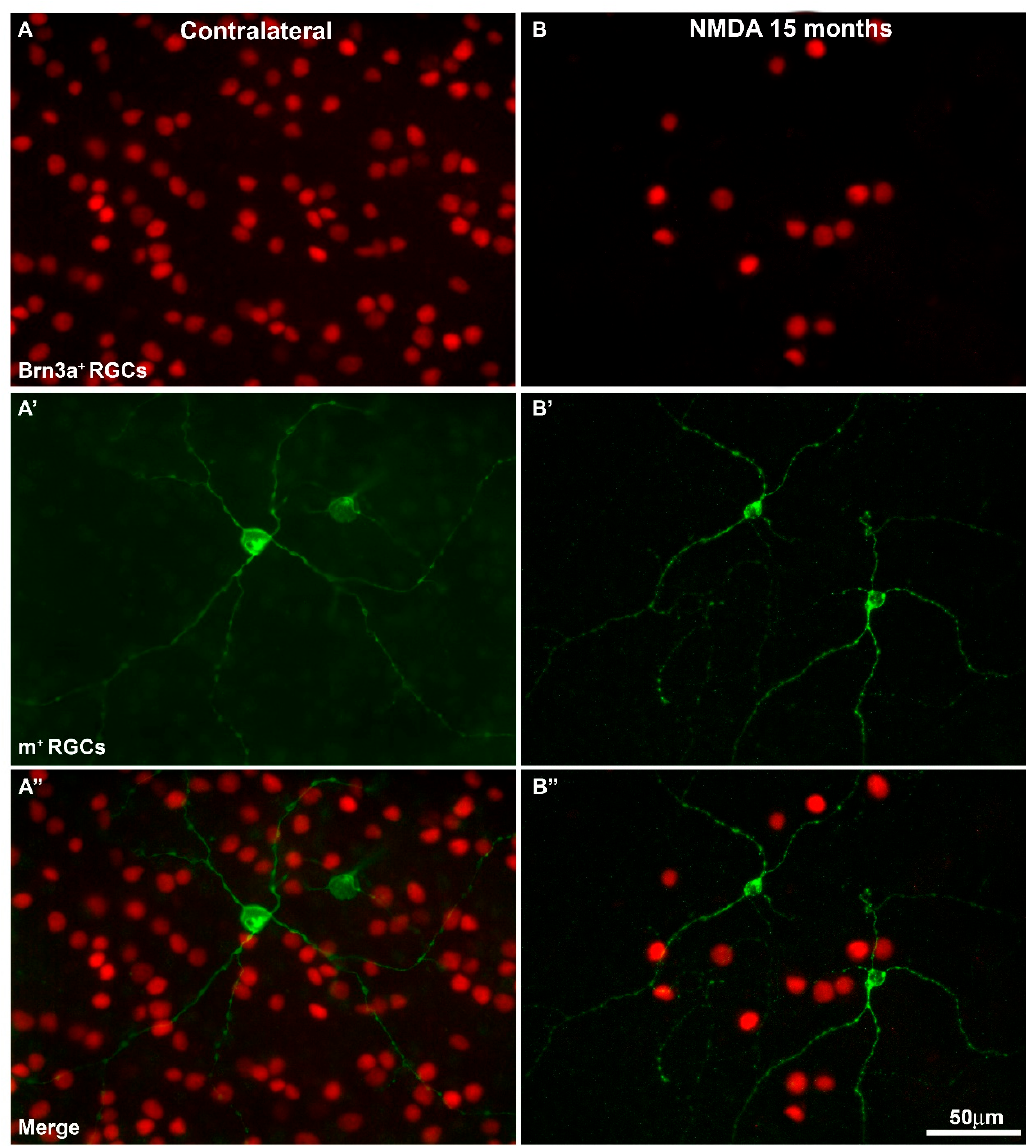
Figure 1. Magnifications from flat mounted retinas showing brain-specific homeobox / POU domain protein 3A positive retinal ganglion cells Brn3a + RGCs ( A , B ) and melanopsin positive retinal ganglion cells m + RGCs ( A’ , B’ ), and both signals (merge) ( A” , B” ) in contralateral ( A , A” ) and N -methyl- d -aspartate (NMDA)-treated retinas ( B , B” ) analyzed at 15 months after the injection. Brn3a labels cell nuclei, while melanopsin allows one to see cell somata as well as primary dendrites on the plane of focus. When both images are overlapped ( A” , B” ), one can appreciate the smaller density of m + RGCs compared to Brn3a + RGCs, as well as the fact that there are no doubly labelled RGCs. Note that 15 months after NMDA injection there are fewer Brn3a + RGCs. Scale bar = 50 µm.